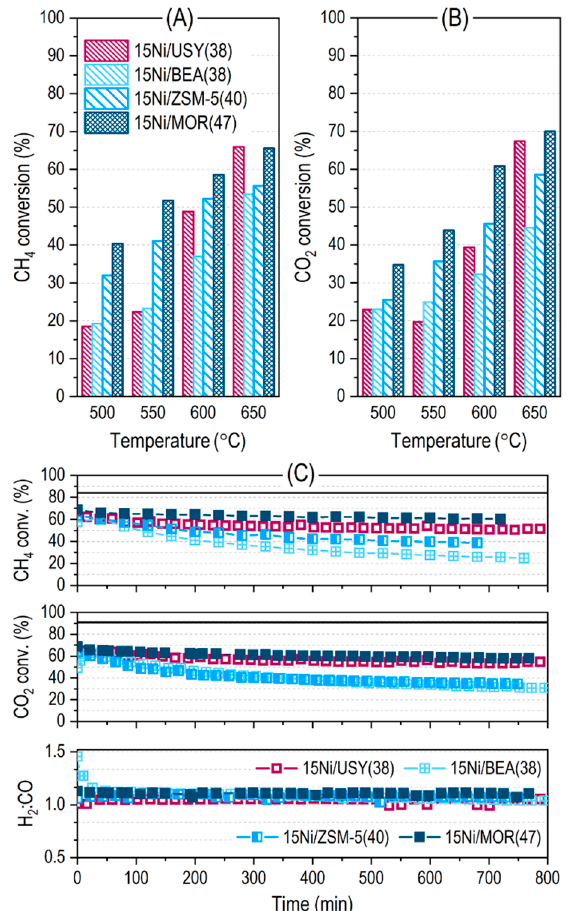
Figure 8. Variation of ( A ) CH 4 and ( B ) CO 2 conversion levels as a function of temperature (500–650 °C) and ( C ) CH 4 conversion, CO 2 conversion, and H 2 :CO molar ratio as a function of time on stream (T = 650 °C) during DRM (P = 1 atm, CH 4 :CO 2 = 1:1, GHSV = 72 L g − 1 h − 1 ) over 15Ni/USY(38), 15Ni/BEA(38), 15Ni/ZSM-5(40), and 15Ni/MOR(47) catalysts. Thermodynamic values of CH 4 , CO 2 , and H 2 :CO (straight black line) in ( C ) were calculated using the HSC 7.1 software.